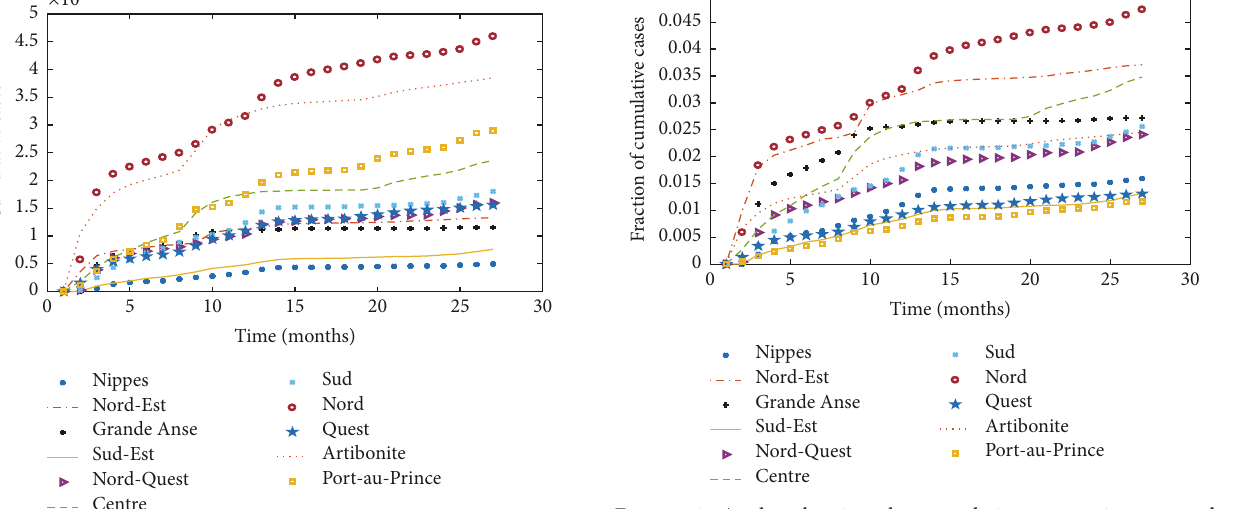
Figure 4: A plot showing the cumulative per capita reported hospitalized choleracases ineach departmentin Haiti from October 30, 2010, to December 24, 2012. Again, the legend is in order of population